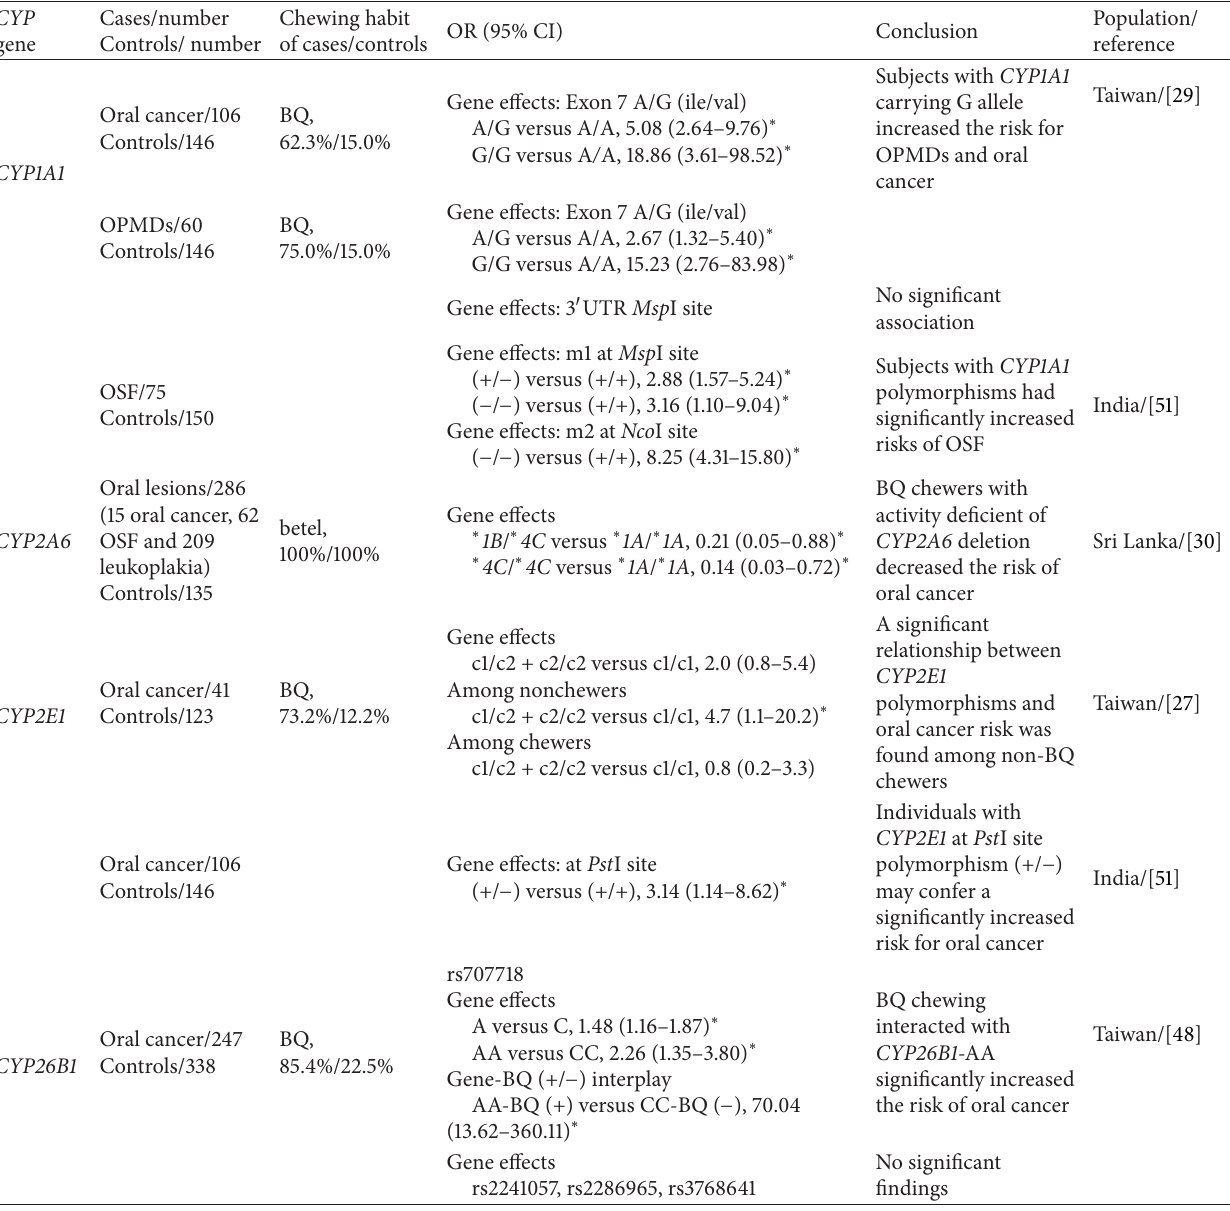
Table 3: The association studies between cytochrome P450 ( CYP ) polymorphism and betel quid-related oral